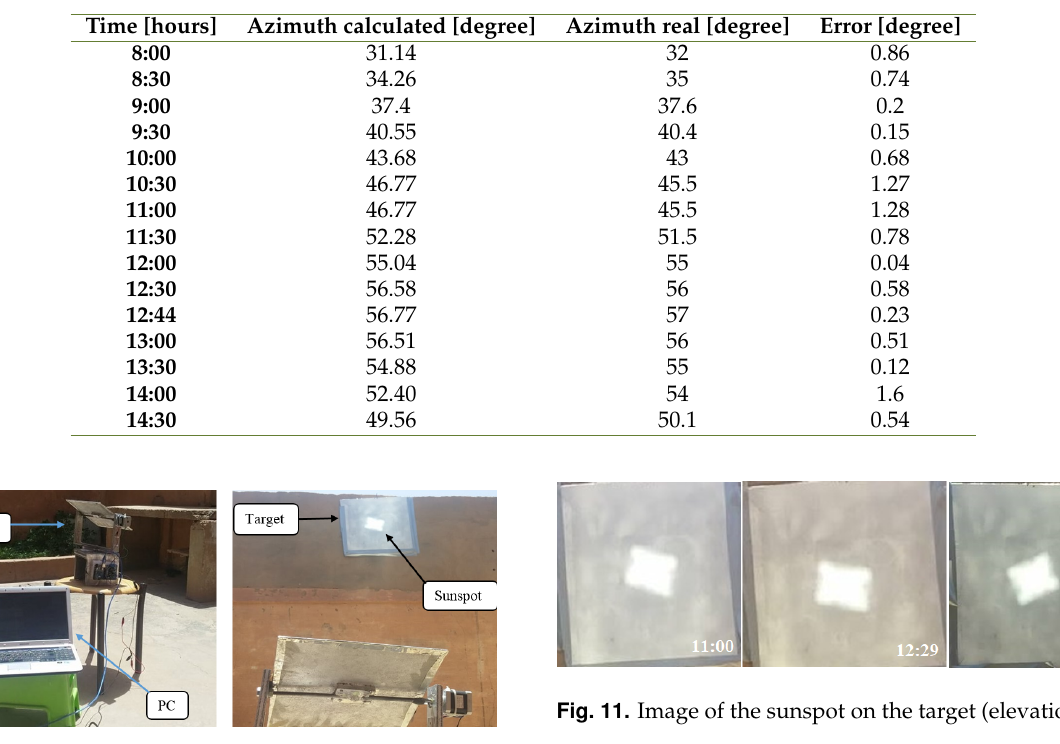
Table 7. Azimuth test result